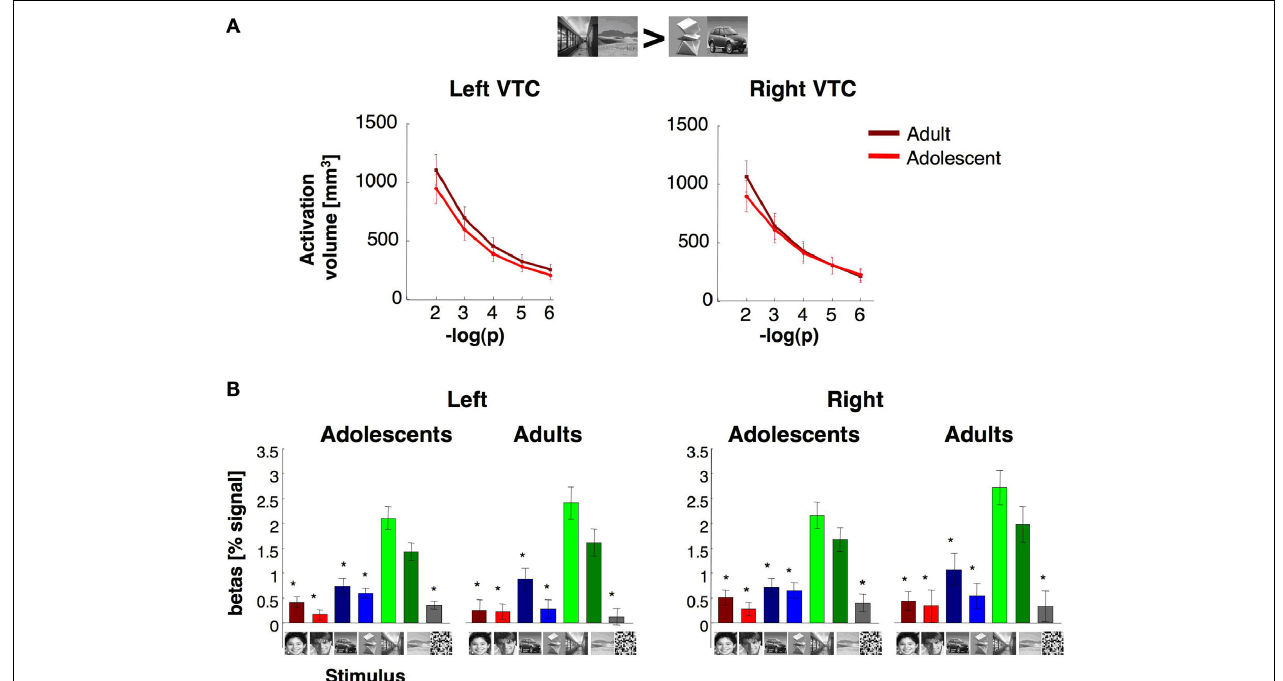
FIGURE 9 | The volume and response of place selective activations in the ventral temporal cortex. (A) The total volume of place selective activations for indoor and outdoor scenes > cars and abstract objects at fi ve different thresholds (10 –2 –10 –6 , uncorrected, shown in minus log base 10 of p ). Light red : adolescents (ages 12–16 years, n = 14); dark red : adults (ages 18–40 years, n = 11). (B) Response amplitudes to visual stimuli across place selective VTC